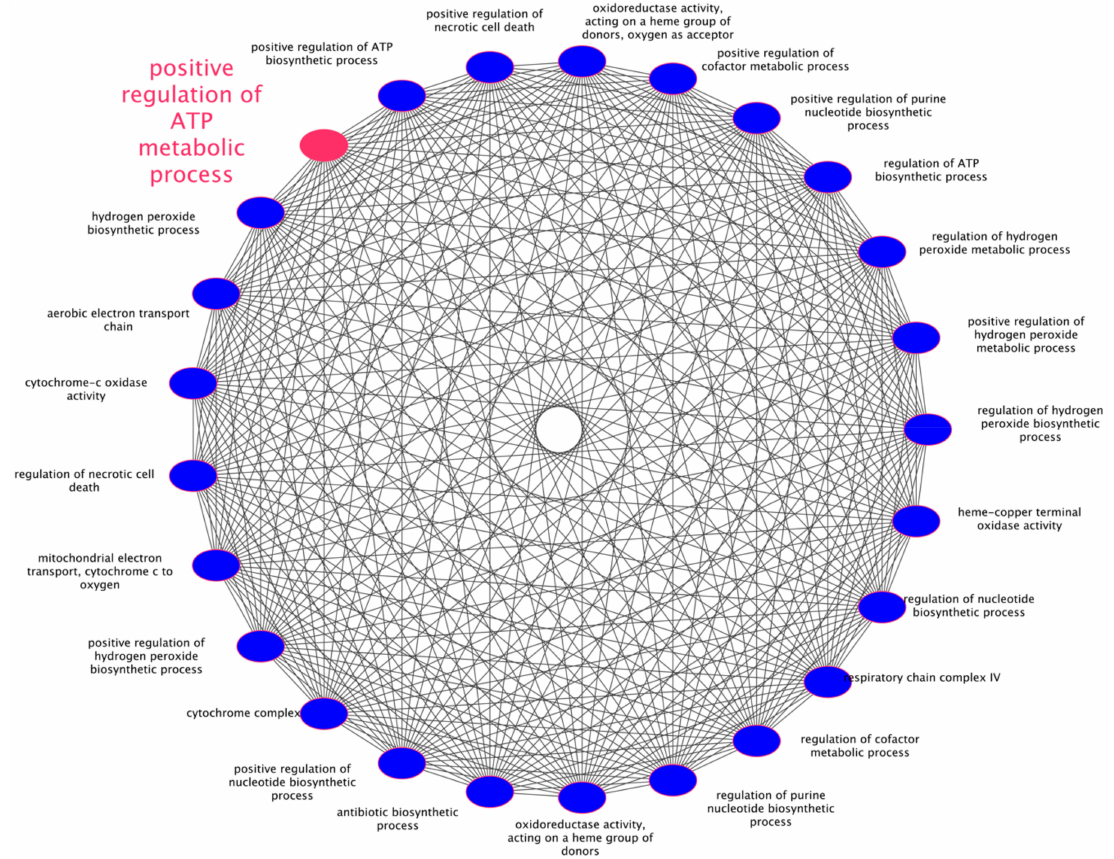
Figure 9. Pathway analysis by Cytoscape and its plugins. The spherical graph represents the significant pathways computed by Cytoscape, ClueGO and CluePedia. It is clear that regulation of adenosine triphosphate (ATP) biosynthesis represents the most altered pathway following the oxidative treatment with